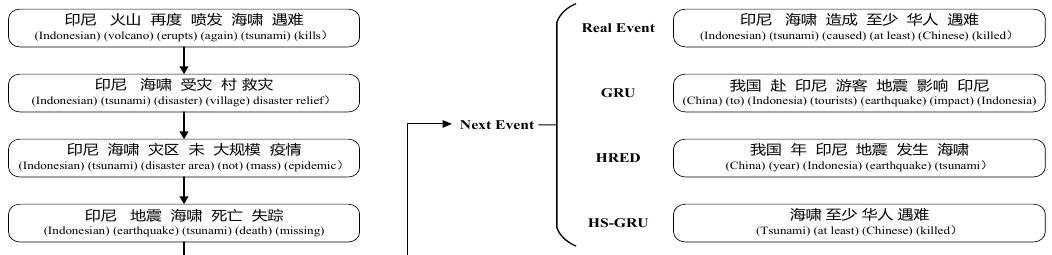
Figure 4. An example of model outputs. Previous four events in the event link are shown on the left. The real last event and the prediction results for different model are shown on the